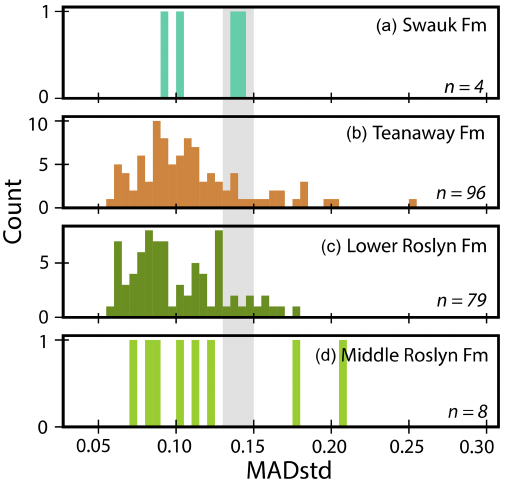
Figure 8. Distribution of MADstd values by lithology, binned by 0.05. Gray bars show the MADstd range 0.13 to 0.15 that is associated with recently active